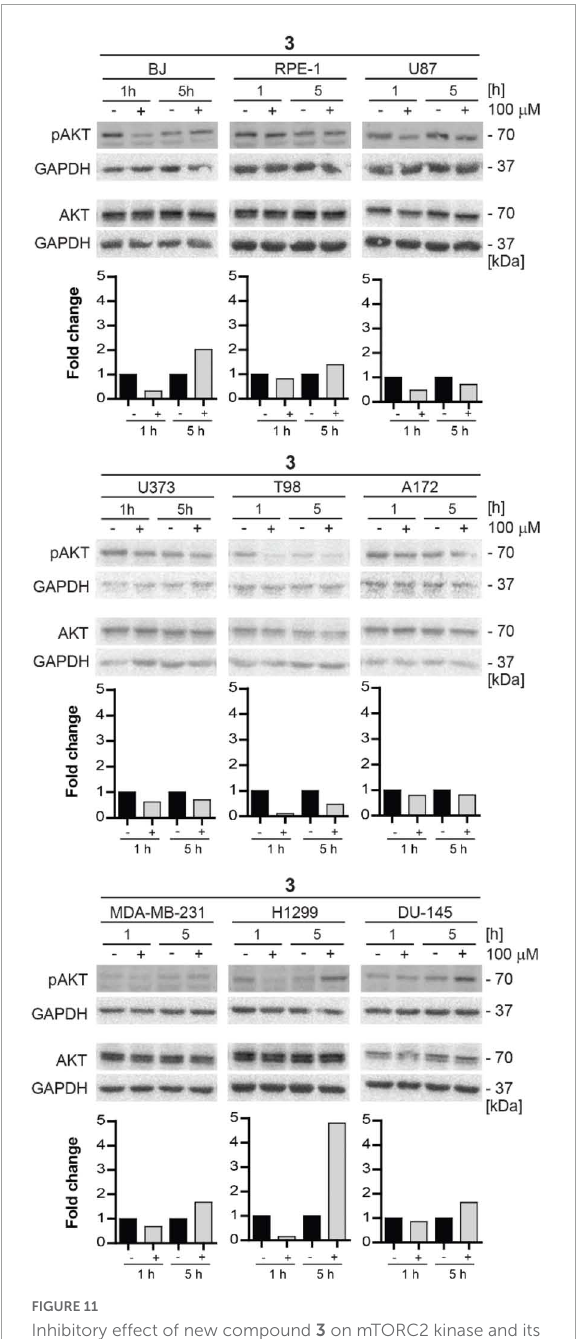
FIGURE11 Inhibitory effect of new compound 3 on mTORC2 kinase and its substrate AKT kinase in various cell lines. Human fibroblasts BJ, immortalized retinal pigment epithelium RPE-1, glioblastoma U87, U373, T98, and A172, breast adenocarcinoma MDA-MB-231, lung cancer H1299, and prostate cancer DU-145 cells were exposed to compound 3 (100 µ M) for 1 and 5 h. Whole-cell lysates were subjected to SDS-PAGE/immunoblotting and probed for phospho-AKT (Ser473) and total AKT with specific antibodies. GAPDH was used as a loading control. Quantitative analysis of immunoblots was done by Image J 1.48v program with GAPDH as the internal